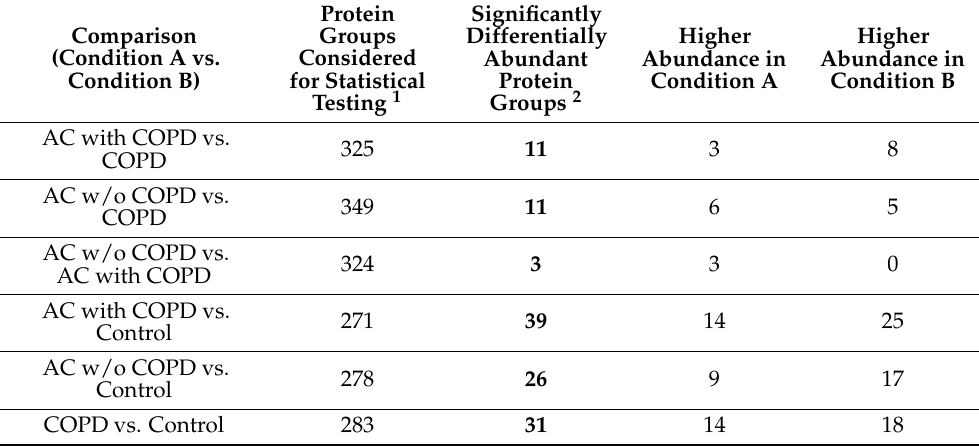
Table 1. Significantly differentially abundant protein